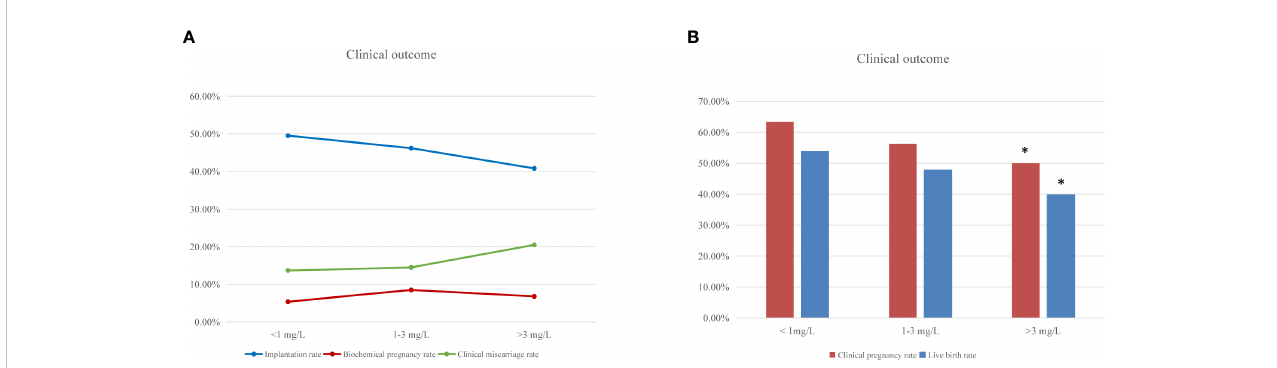
FIGURE 1 IVF clinical outcomes according to woman ’ s hsCRP level. (A) Percentage of implantation, biochemical pregnancy and clinical miscarriage rate after fresh embryo transfer cycles among women with low (<1 mg/L), medium (1-3 mg/L) and high (>3 mg/L) hsCRP level. (B) The frequencies of clinical pregnancy and live birth after fresh embryo transfer cycles according to the hsCRP levels. “ * ” means statistically signi fi cant difference (P<.0.0167) for clinical pregnancy and live birth rate in the high hsCRP group compared with low hsCRP